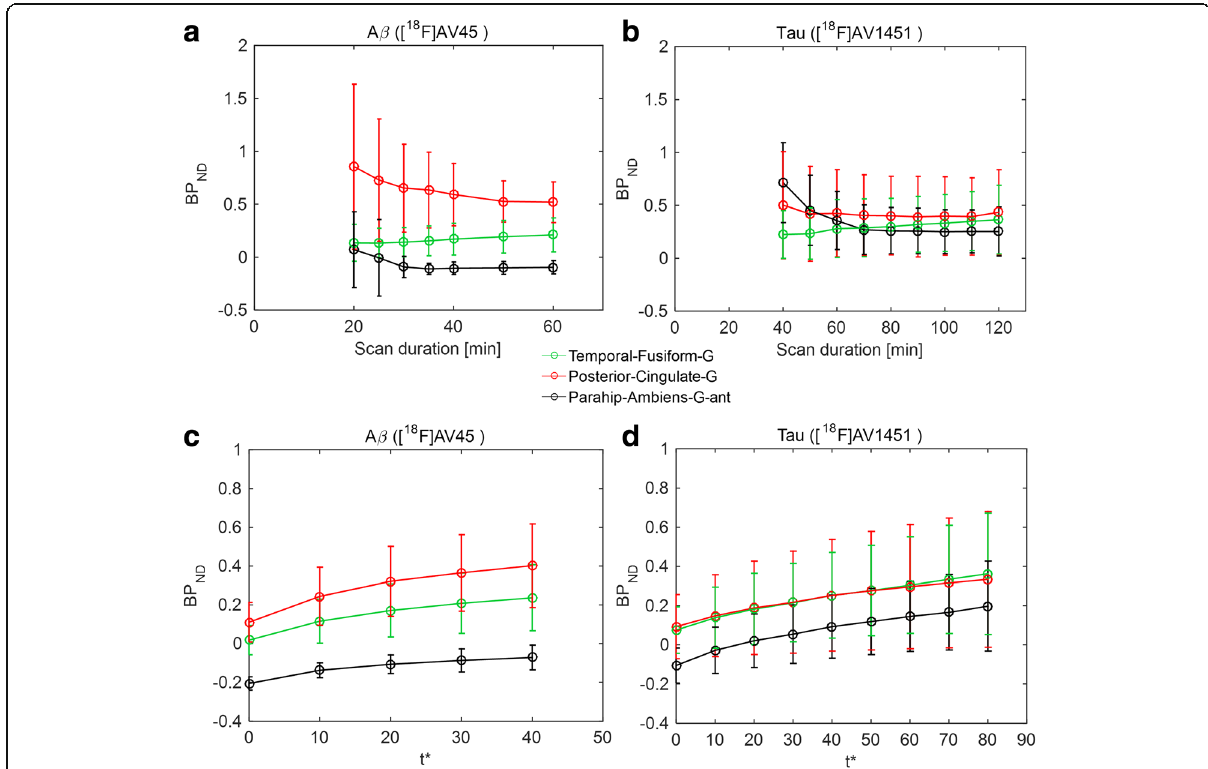
Fig. 2 Estimated mean (the circles) and variation (vertical bars) of regional BP ND values using SRTM ( a , b ) and reference Logan graphical analysis ( c , d ) with cerebellum grey as reference region for three example regions over all subjects for A β ( a , c ) and tau ( b , d ) dynamic PET scans. t * indicates the starting time of reference Logan graphical analysis